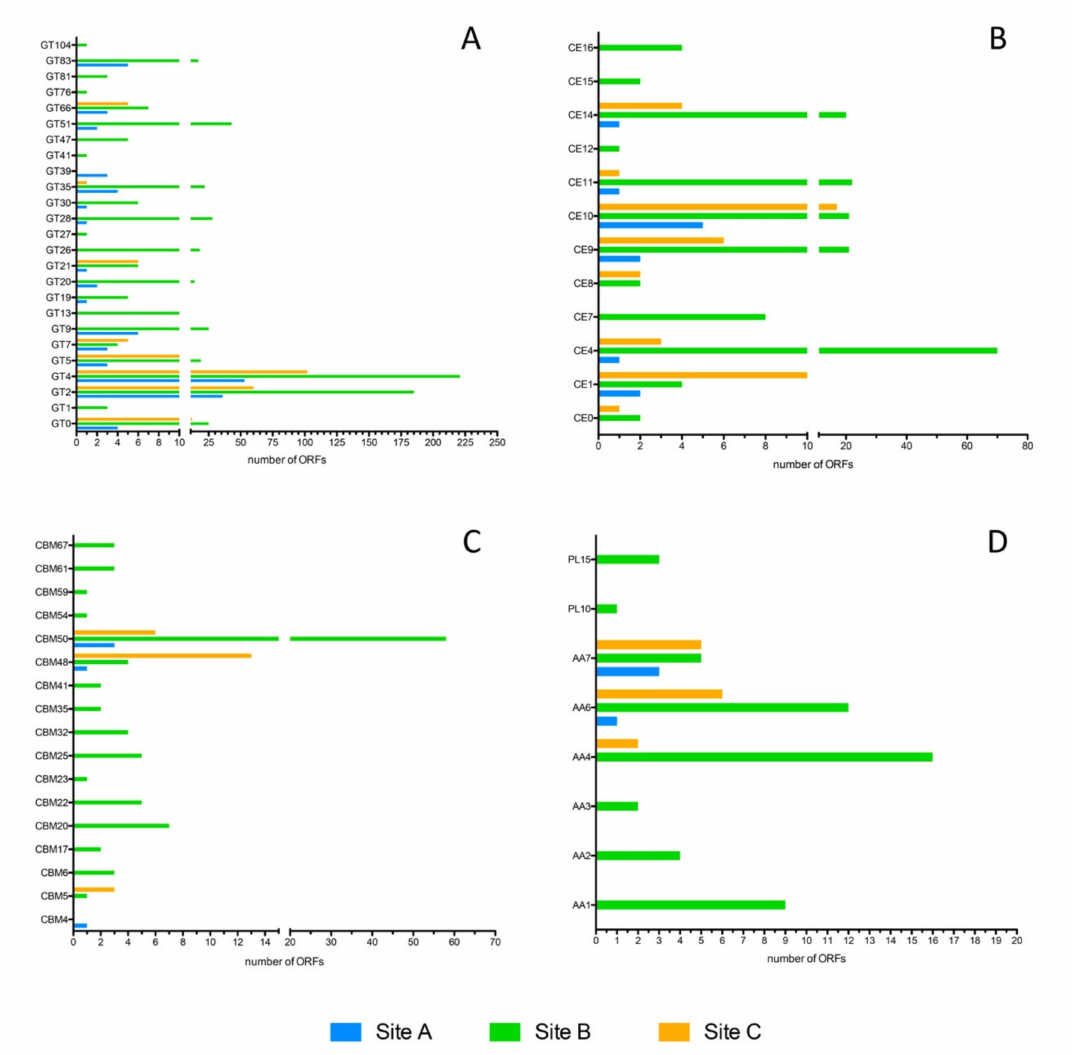
Figure 11. Distributionofthe( A )glycosyltransferase, ( B )carbohydrateesterases, ( C )carbohydrate-binding modules, ( D ) auxiliary activities and polysaccharide lyases among the Pisciarelli sites. The ORFs number assigned to each family from the three samples is